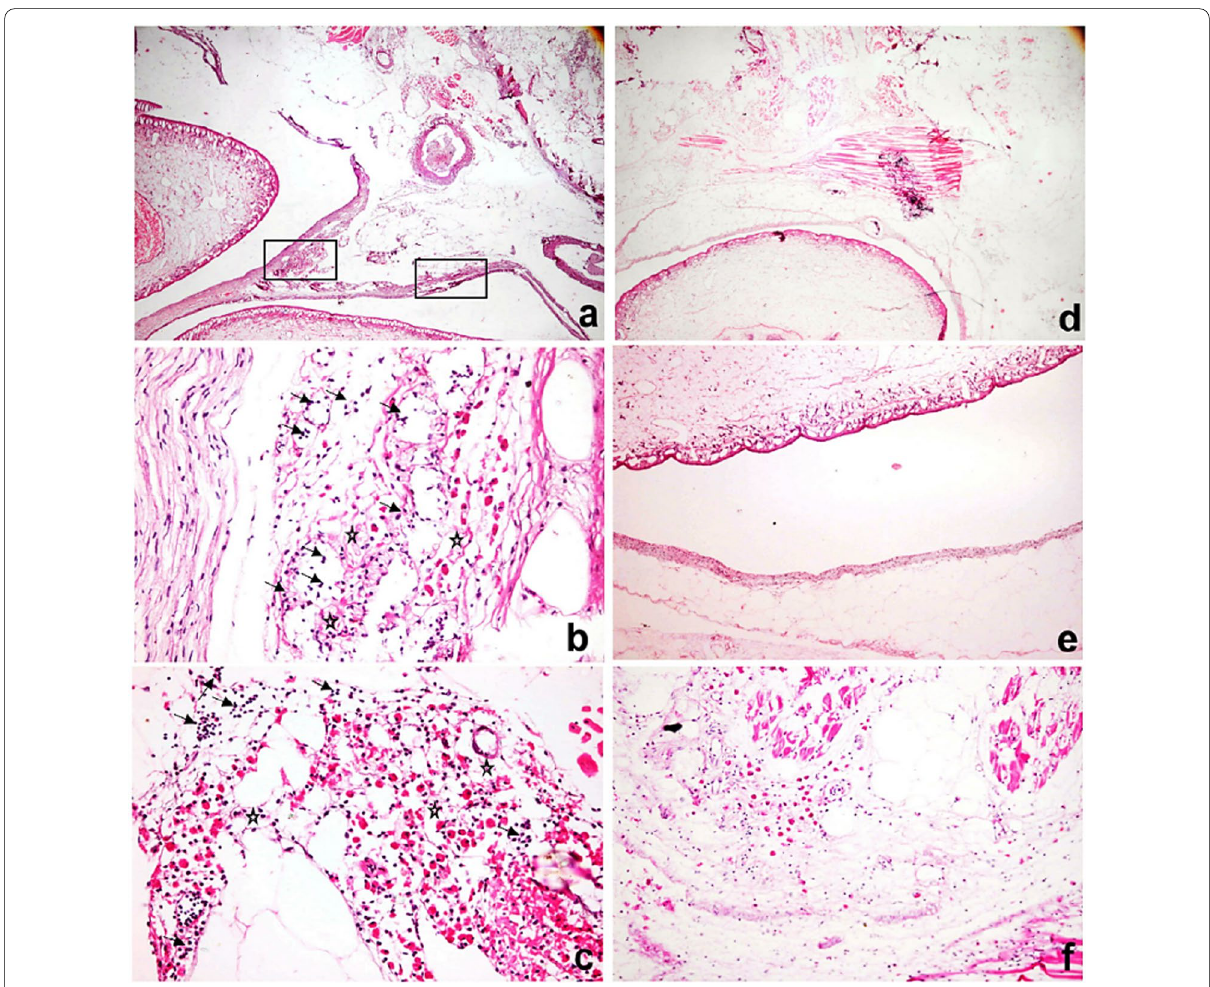
Fig. 4 a c Histological section of fish gill arch and pseudobranch of control untreated group showing; a Presence of large EMC enclosed by dense − fibrous capsule with destruction of the adjacent tissue structures with intense inflammatory cells infiltration (insert box) ( and incorporated in gill arch adipose tissue with intense inflammatory cells infiltration mainly EGCs admixed with mononuclear cells (arrows) and edema (asterisks) ( 200). c Intense EGCs infiltration with myocytolysis and necrosis of muscle fibers ( × arch of treated group showing, d presence of large encysted metacercaria enclosed by dense fibrous capsule with no destruction of the adjacent tissue structures ( 40). e Intact adipose tissue with no inflammatory reaction ( × myocytes